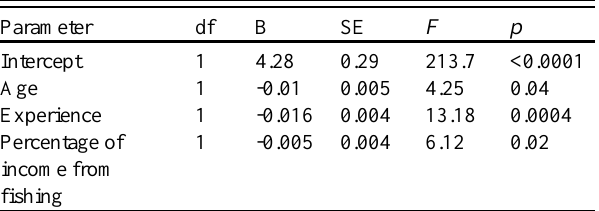
Table 2. Results of the general linear model testing the combined effects of the eight personal and business characteristics on Queensland commercial fishers’